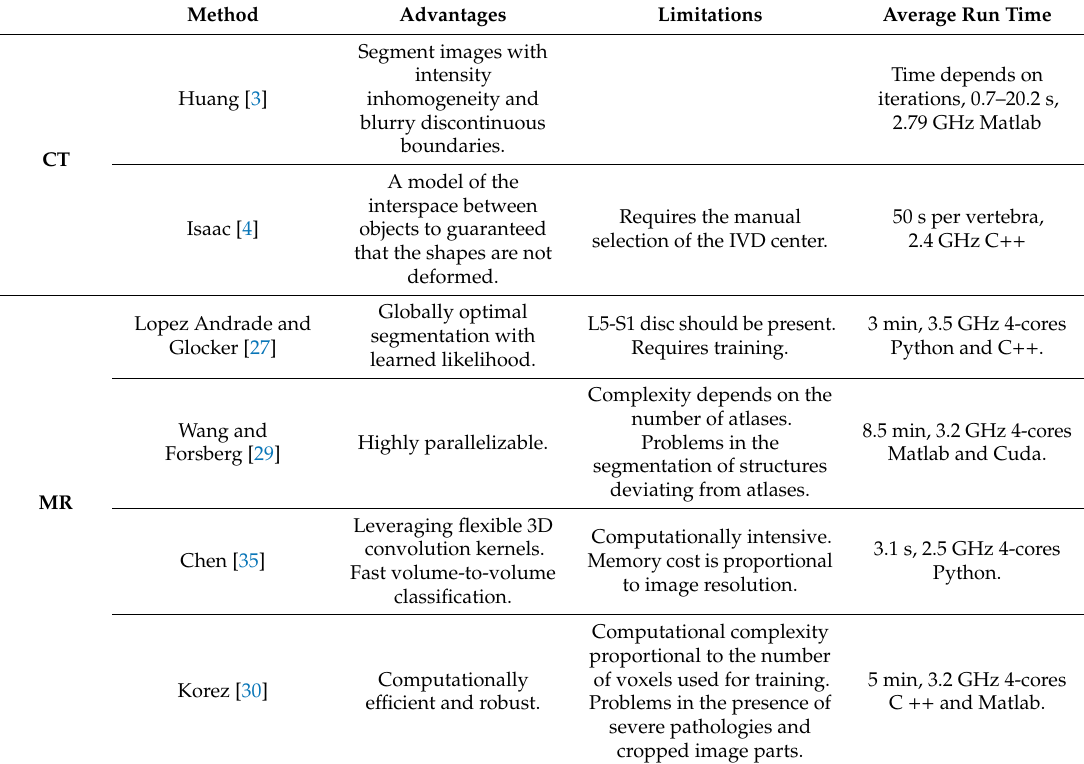
Table 1. Summary of limitations of state-of-the-art methods